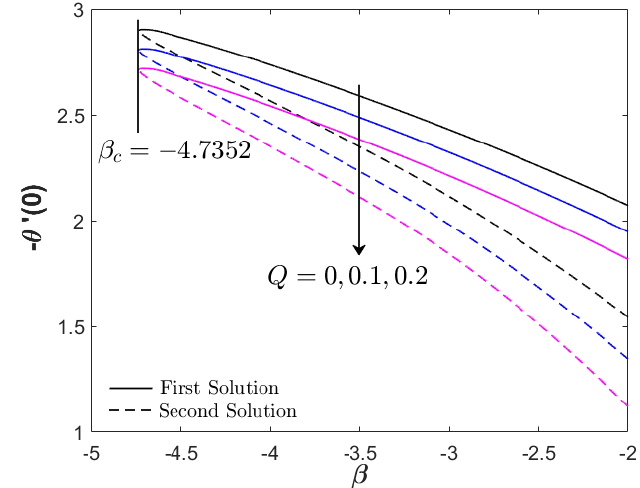
β = − remained for all values of Q . 4.7352 c